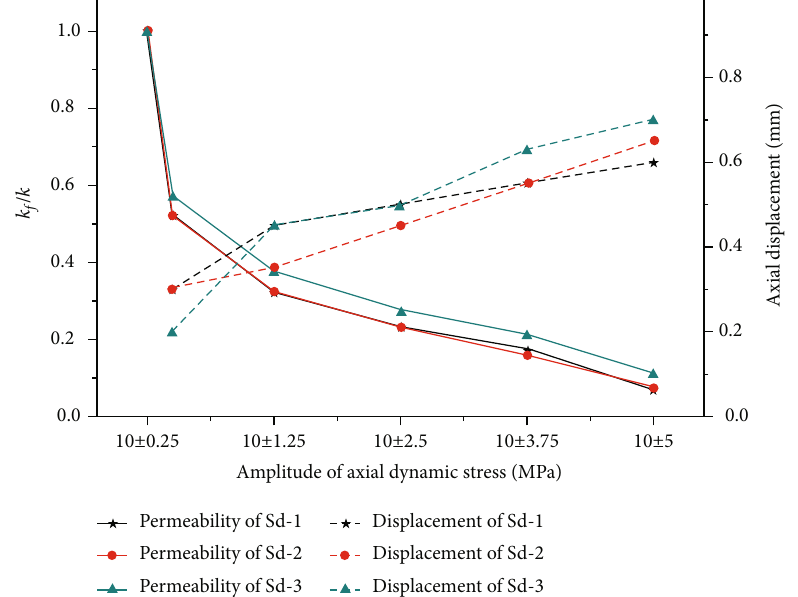
Figure 6: Permeability evolution and axial displacement of Sd-1, Sd-2, and Sd-3 under di ff erent amplitudes of axial stress of